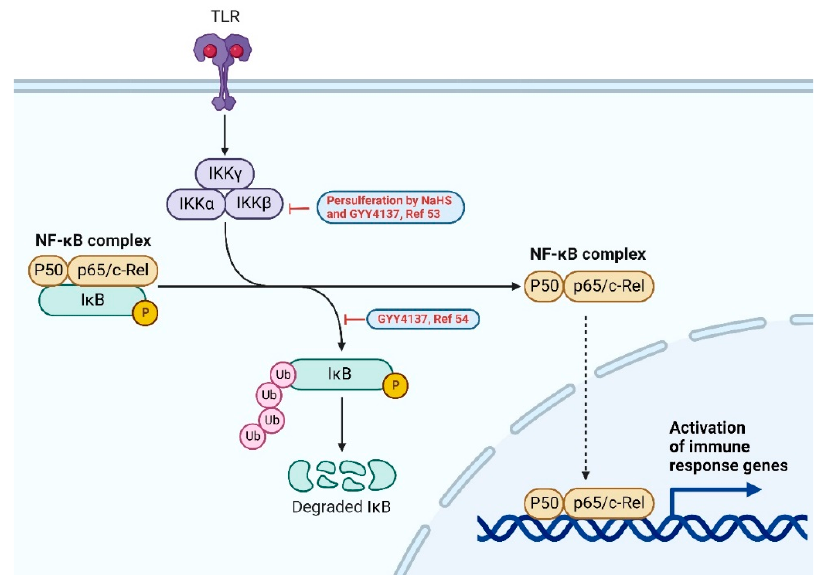
Figure 4. NF- κ B signaling pathway. H 2 S donors (GYY4137 and NaHS) suppress the upregulation of phospho-I κ B, as shown in red, and LPS-induced inflammation [53,54]. Created with BioRender.com. Cisplatin is a chemotherapy agent which can cause extensive nephrotoxicity. In cisplatin-treated renal tubular cells, H 2 S donors (NaHS and GYY4137) persulfidated STAT3 and IKK β , resulting in the suppression of an NF- κ B-mediated inflammatory cascade, which could potentially ameliorate renal damage caused by chemotherapy [53]. In murine macrophage RAW264.7 cells, LPS treatment increased the p-I κ B and nuclear translocation of p65. The addition of GYY4137 suppressed the upregulation and therefore inhibited the LPS-induced activation of RAW264.7 cells [54].